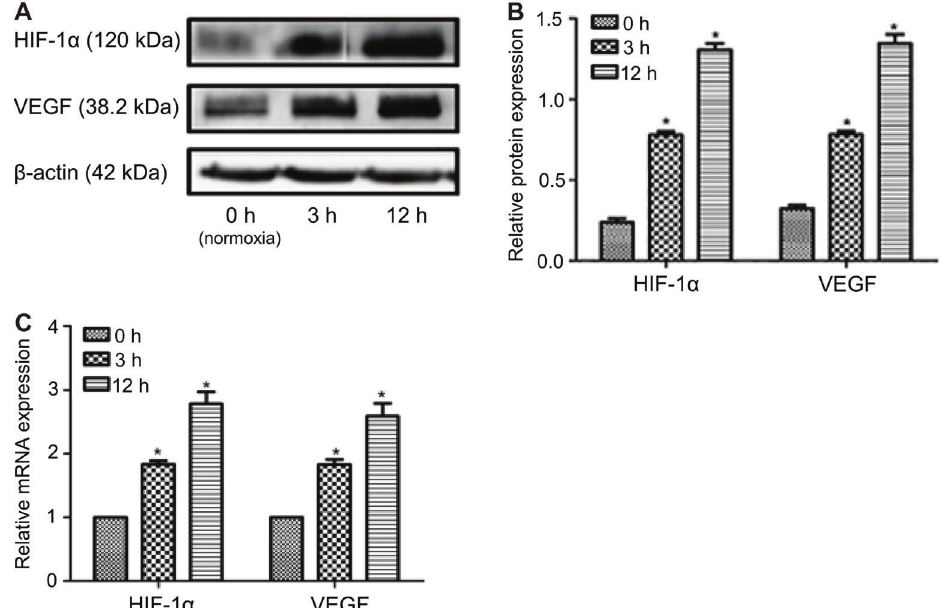
Figure 1. A , HIF-1 a and VEGF protein expression. B , Histogram of HIF-1 a and VEGF protein expression. C , Histogram of HIF-1 a and VEGF mRNA expression. Data are reported as means ± SD. *P o 0.05 compared with normal control group